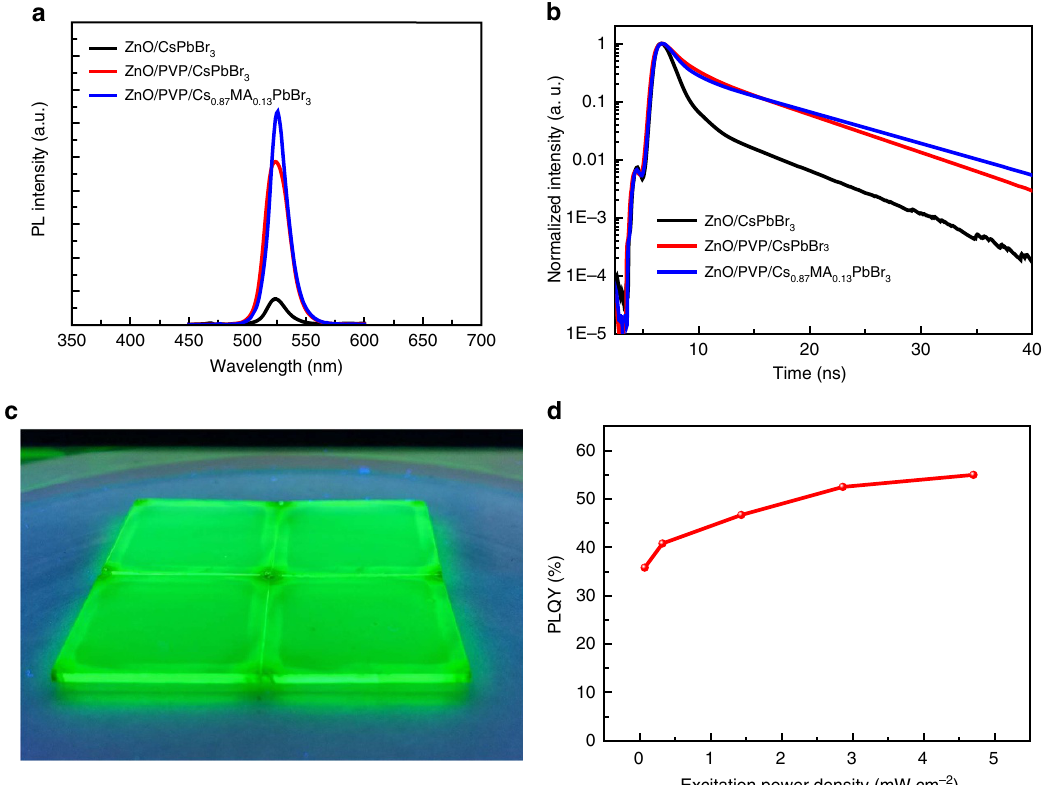
Figure 2 | PL behaviour of CsPbBr 3 films deposited under different conditions. ( a ) Steady-state PL of CsPbBr 3 films on ZnO, ZnO/PVP and Cs 0.87 MA 0.13 PbBr 3 film on ZnO/PVP, respectively, here PVP is polyvinyl pyrrolidine, MA is CH 3 NH 3 . ( b ) Time-resolved PL of CsPbBr 3 films on ZnO and ZnO/PVP and Cs 0.87 MA 0.13 PbBr 3 on ZnO/PVP. ( c ) PL image of Cs 0.87 MA 0.13 PbBr 3 films on ZnO/PVP under ultraviolet lamp excitation. ( d ) PLQY of Cs 0.87 MA 0.13 PbBr 3 as a function of excitation power